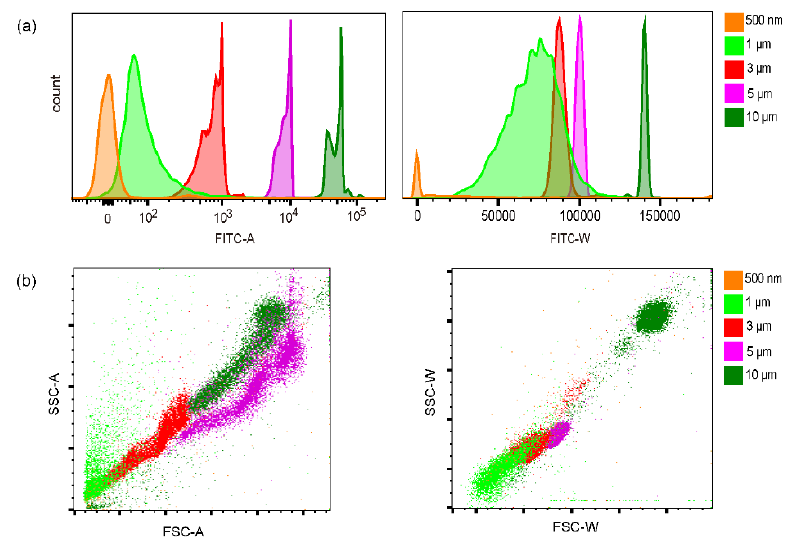
Figure 4. Quanti fi cation of microbeads by FACS Aria II fl ow cytometer. ( a ) The fl uorescence ampli- tude and width. ( b ) The front sca tt ering and side sca tt ering